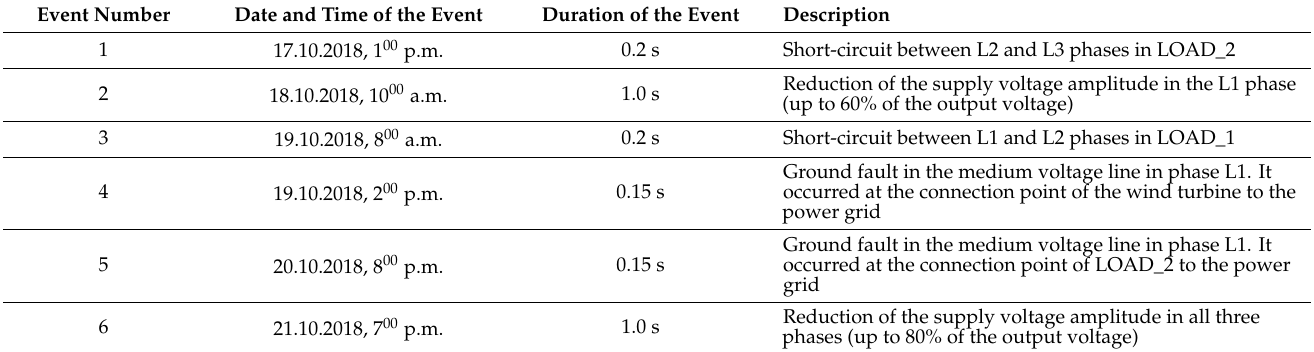
Table 3. Schedule of random events of the power system